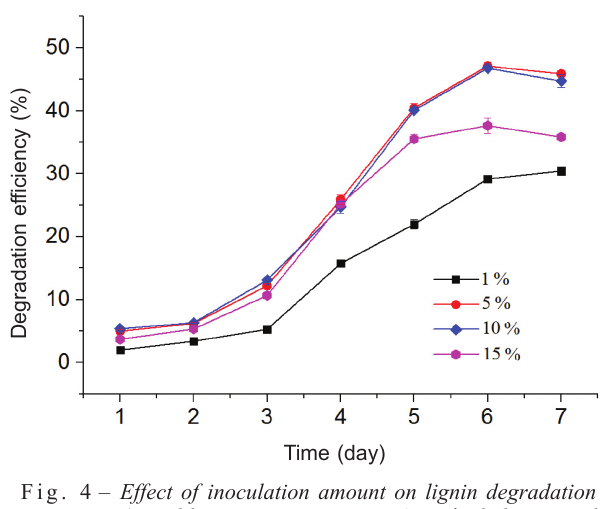
Fig. 4 – Effect of inoculation amount on lignin degradation (initial lignin concentration = 1 g L –1 , shaking speed